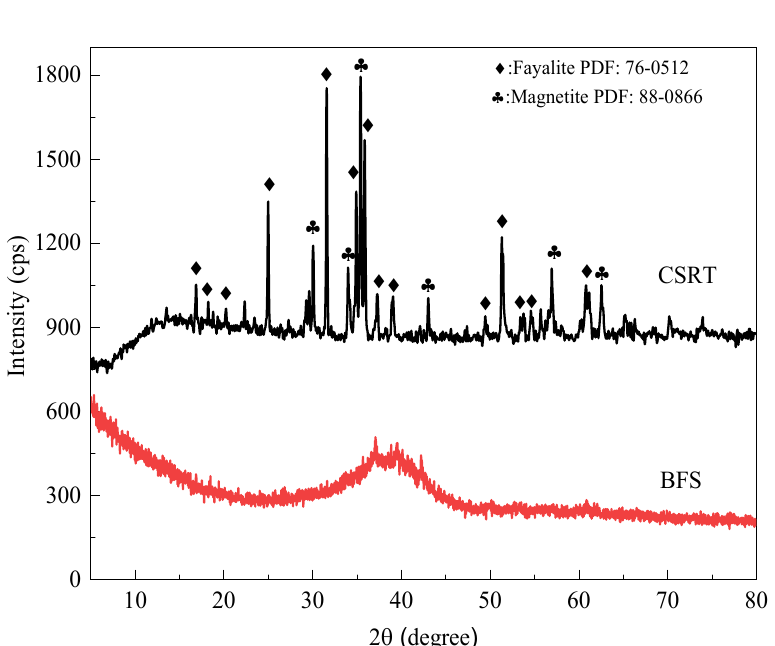
Figure 1. XRD patterns of the CT and BFS. Table 1. Chemical composition of the CT and BFS.